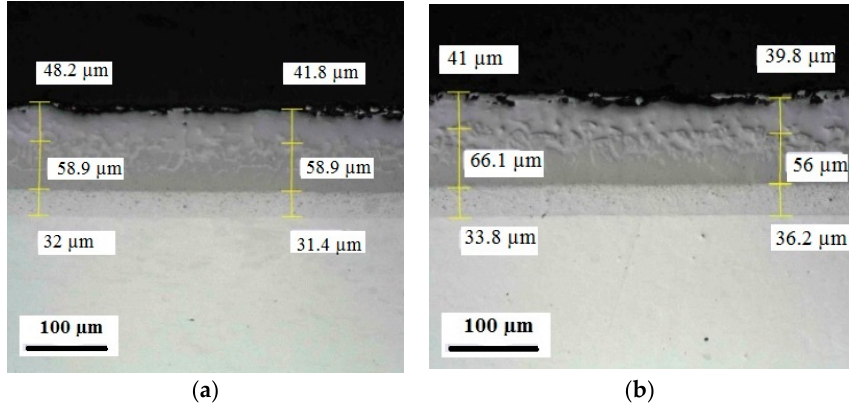
Figure A11. Microscopic images of the cross-section of 316-A ( a ) before and ( b ) after the low-temperature corrosive attack after 168 h.